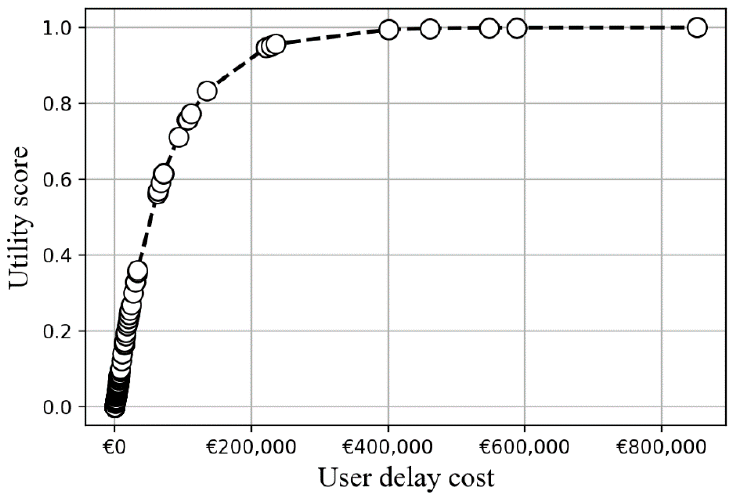
Figure 11. Utility plot of user delay cost.